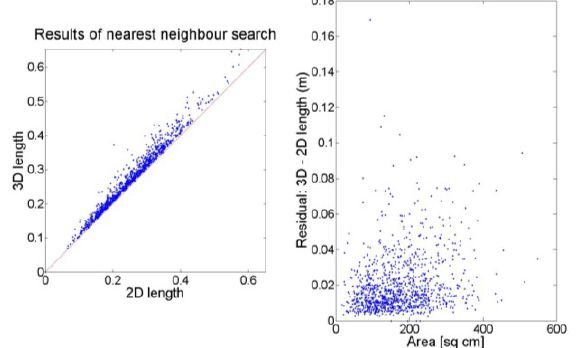
Figure 5: Left: Differences between 2D and 3D lengths; Right: residual vs. area of projected shell surface